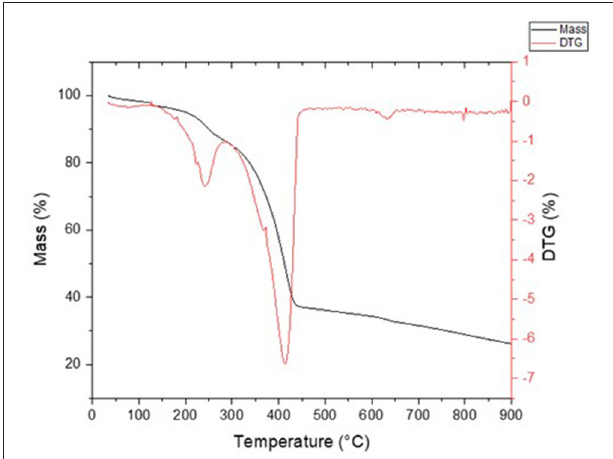
TABLE 2 | Elemental Input data for thermochemical